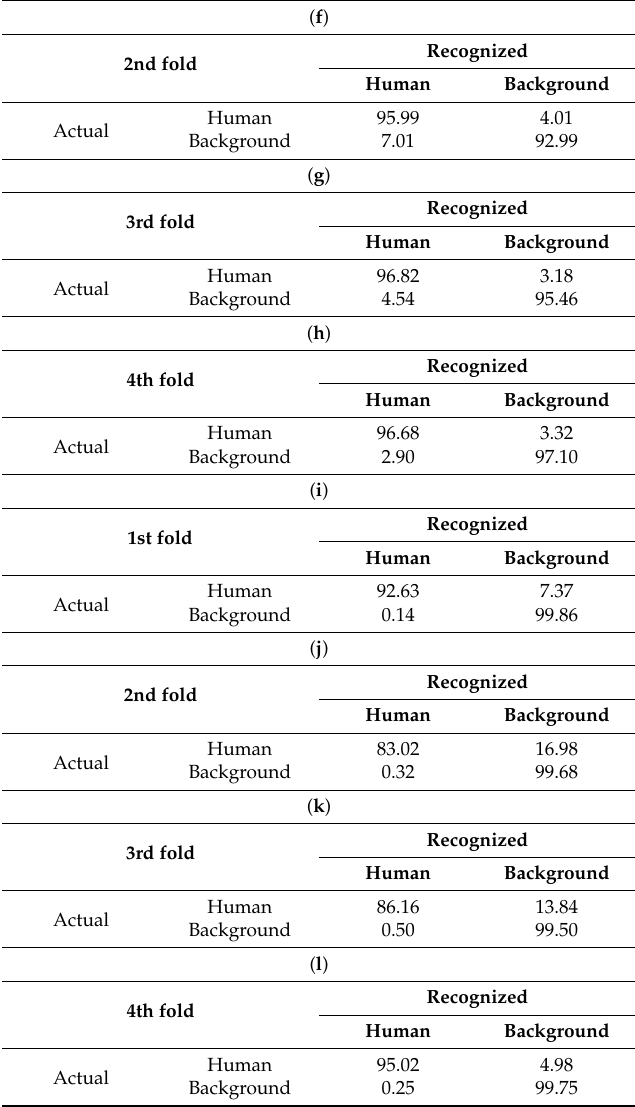
Table 5. Confusion matrix of recognition accuracies with HE processed images by four-fold